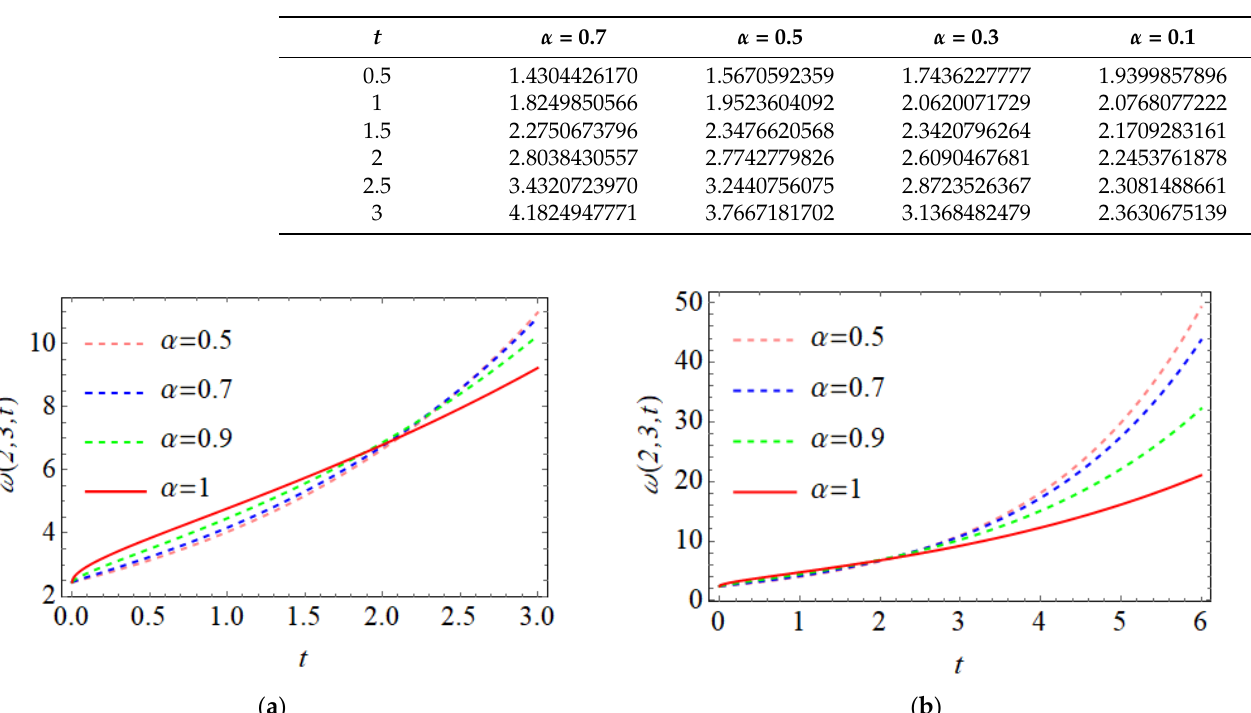
Figure 1. The behaviour of the analytical approximate FSS for nonlinear time-FBPM (15) at various values of α and λ = 0.5; ( a ) for t ∈ [ 0,3 ] , ( b ) for t ∈ [ 0,6 ]